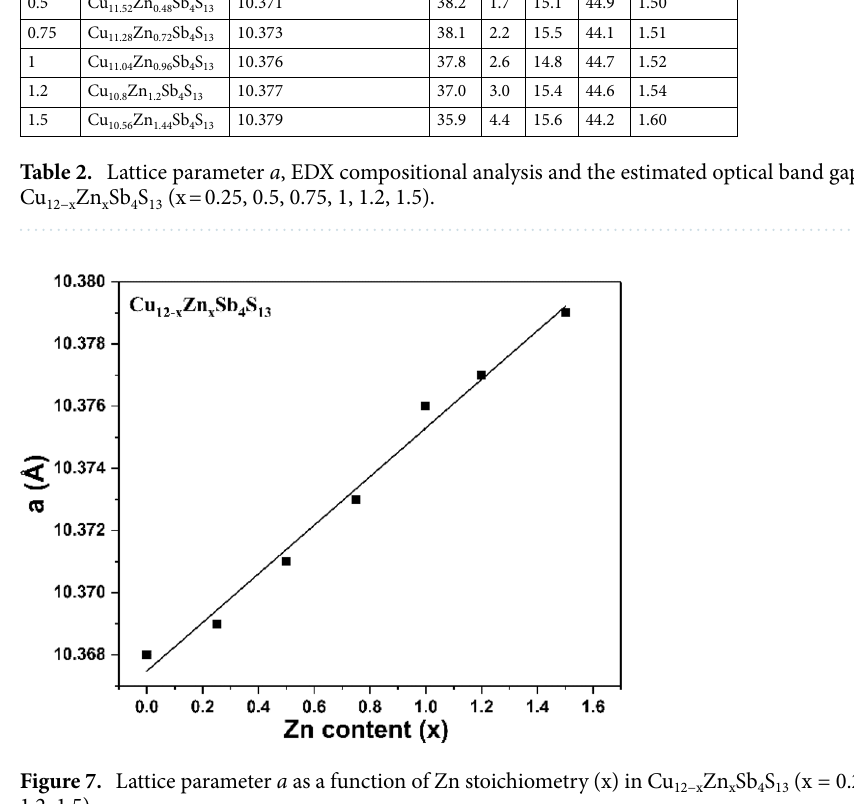
Figure 7. Lattice parameter a as a function of Zn stoichiometry (x) in Cu 12−x Zn x Sb 4 S 13 (x = 0.25, 0.5, 0.75, 1, 1.2,